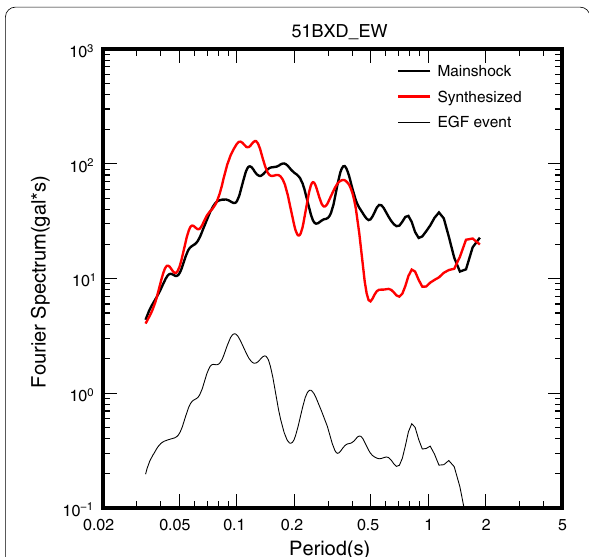
Fig. 12 Observed and synthesized acceleration Fourier spectra in the EW component at Station 51BXD. The black, red, and thin lines denote the acceleration Fourier spectra for the observed and synthesized ground motions of the best-fit characterized source model, and the observed ground motions of the EGF event, respectively. The Fourier spectra are smoothed by use of a logarithmic window function (Konno and Omachi